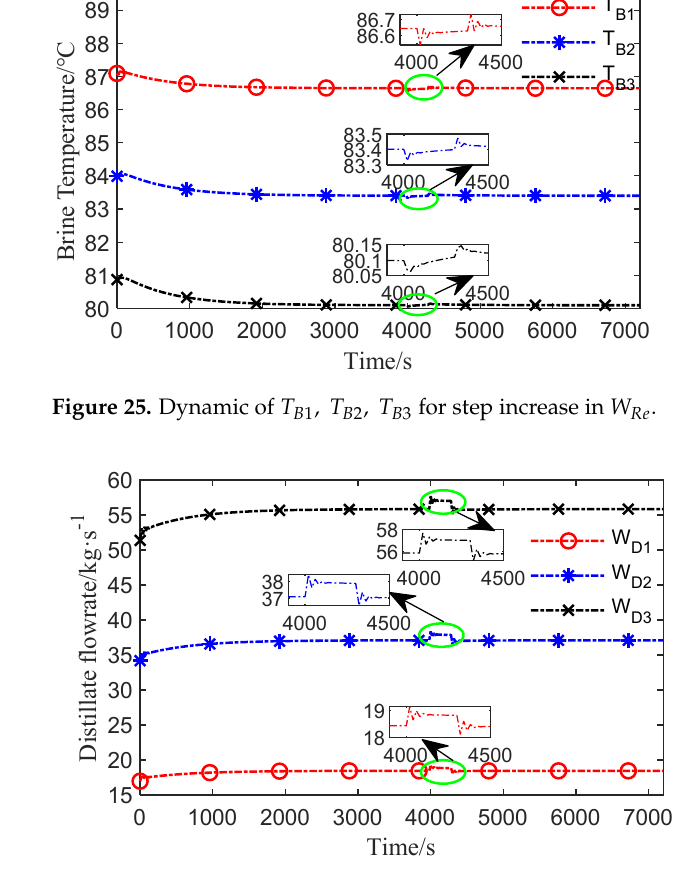
Figure 26. Dynamic of for step increase in Re